Question: Summarize what this figure shows in one sentence.
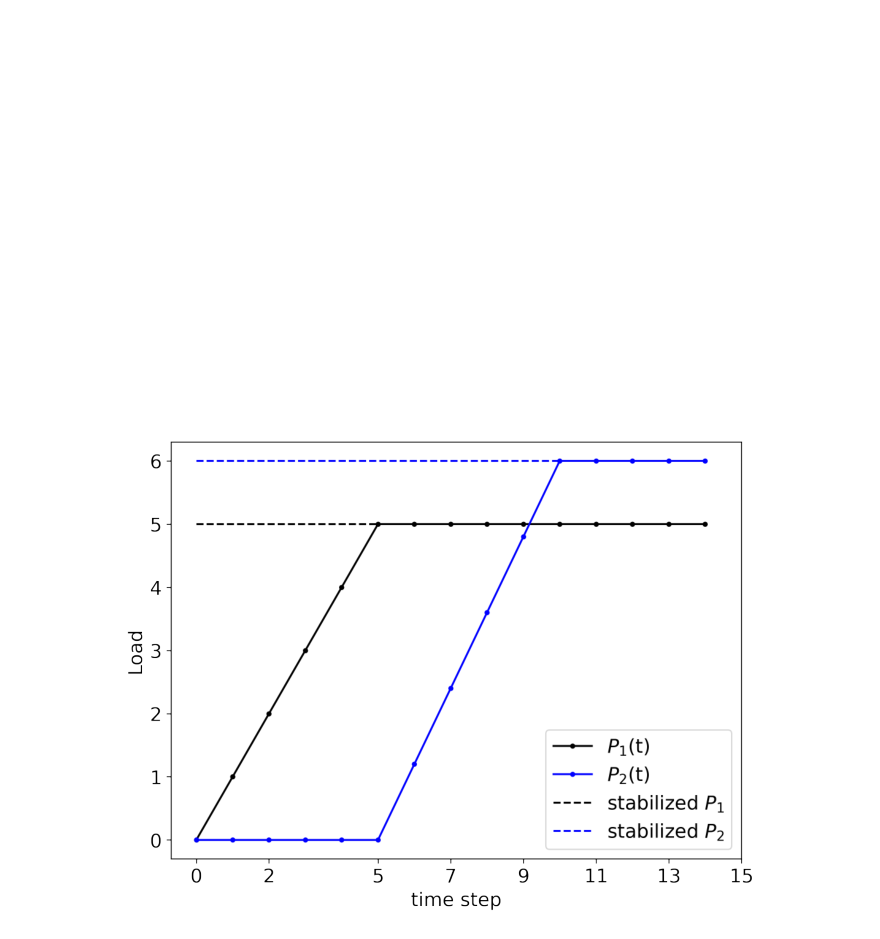
Answer: The pressure loads P1(t) and P2(t) as they change over time. The scalars P1 and P2 are the stabilized values of the loads.